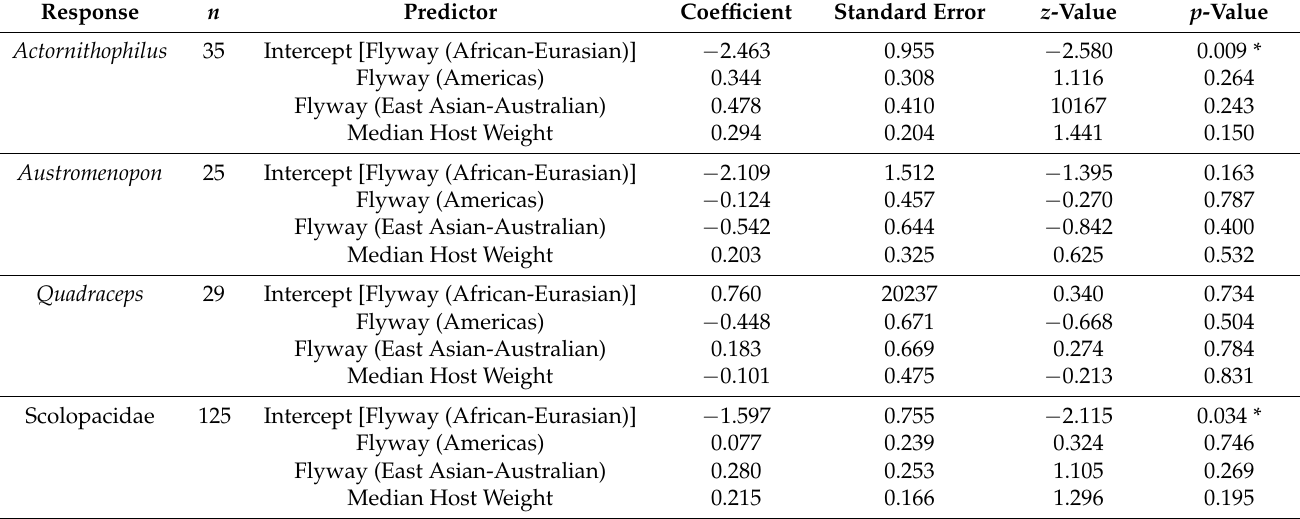
Table 8. Summary of GLMM (beta distribution and logit-link function) of the effects of flyway and host weight on the prevalence of lice. An asterisk (*) designates the only statistically significant